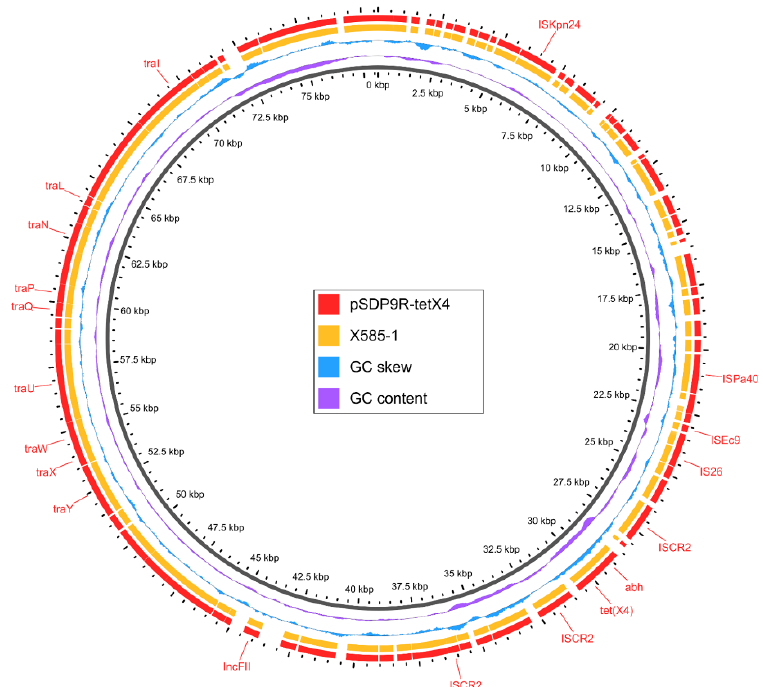
Figure 4. Circular comparison of the tet (X4)-bearing plasmid pSDP9R-tetX4 (NZ_MW940621) available in NCBI database and draft genome sequences of X585-1. The outermost circle with arrows denotes the reference plasmid pSDP9R-tetX4.